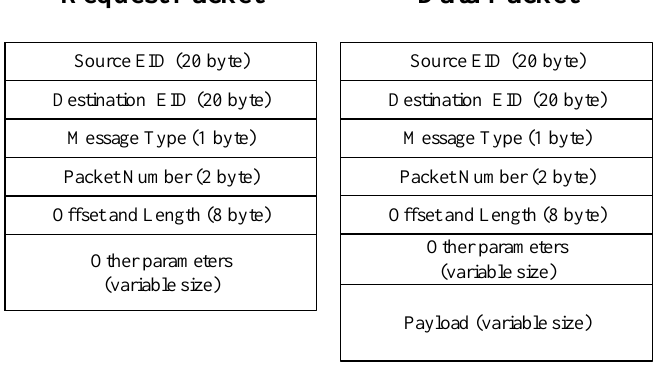
Figure 2. Packet format in the ICN transport